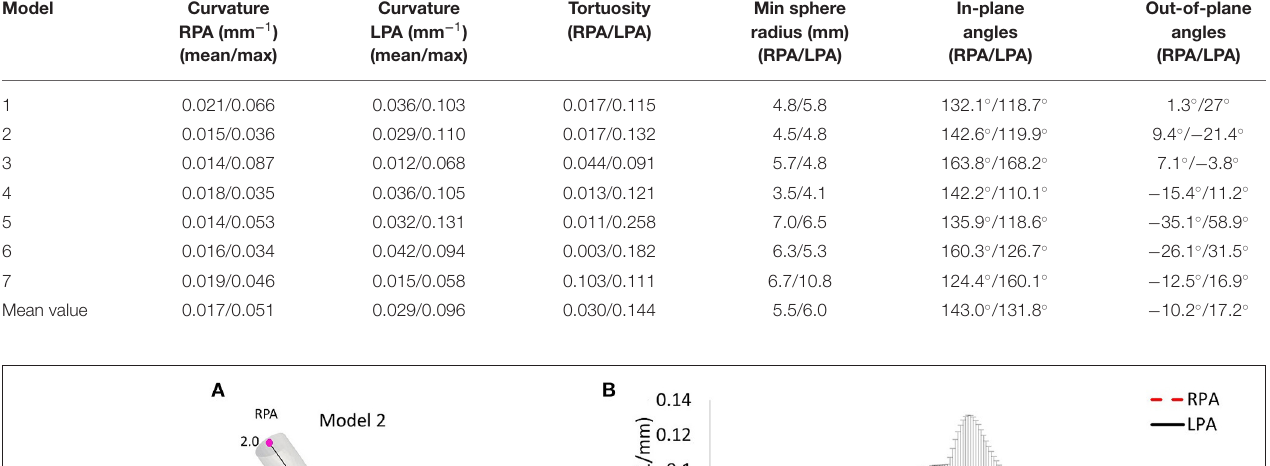
TABLE 3 | Geometric analysis of the patient-specific models: curvature, tortuosity, minimum inscribed sphere radius along the daughter branches, and in-plane and out-of-plane angles. Model